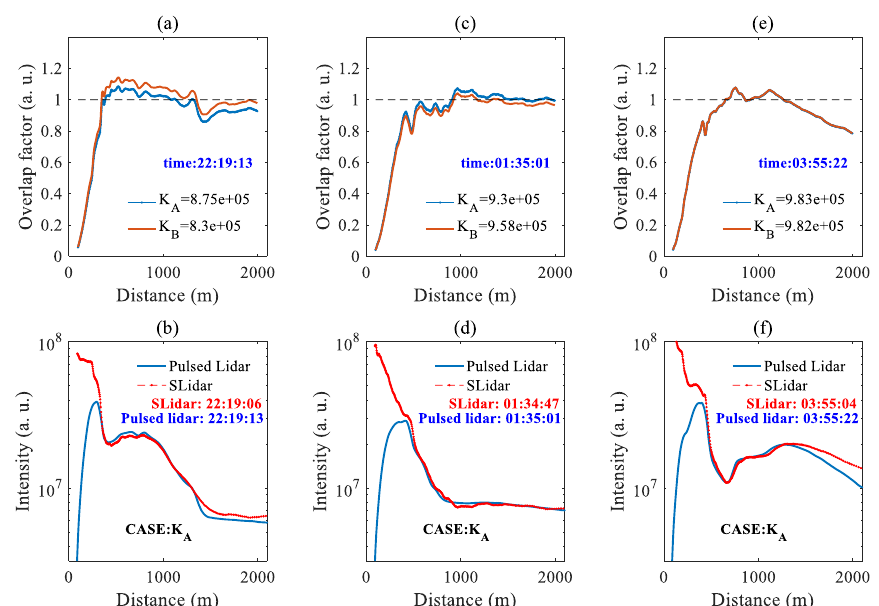
Figure 6. ( a ), ( c ) and ( e ): overlap factors of the pulsed lidar system, which were calibrated through simultaneous measurements employing the SLidar system and the pulsed lidar system. ( b ), ( d ), and ( f ): the lidar curves measured by the pulsed lidar system and the SLidar system, where the lidar signal measured by the SLidar system has been multiplied by the system constant K A . K A was referred to that the overlap factor was obtained by using the system constant K A (500–1500 m), while K B was referred to that the overlap factor was evaluated by using the system constant K B (1050–1500 m).